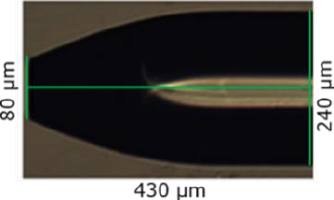
Figure 2. Microscope picture of etched CPC fiber tip with its specific dimensions. The bright zone from the right side of the picture to the center is a reflection from the microscope light source.